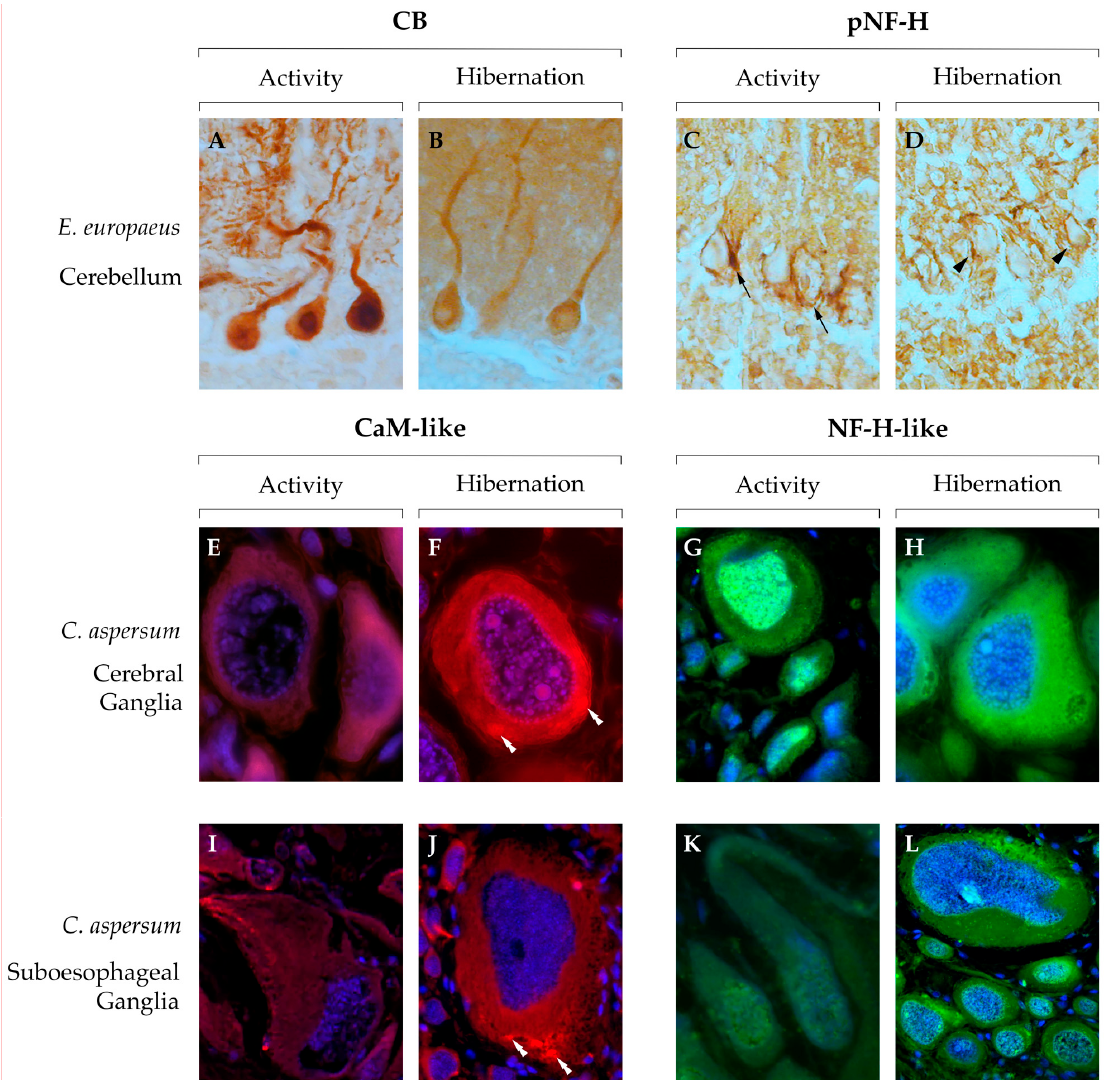
Figure 3. Comparison of immunohistochemistry staining for CBPs and NF-H between activity and hibernation in vertebrate (European hedgehog, A – D ) and invertebrate (garden snail, E–L ) models. In the cerebellum of active hedgehogs, the cytoplasm and dendritic tree of Purkinje neurons showed strong CB labeling ( A ), while a visible decrease was detected after a long period of hibernation ( B ). NF-H immunopositivity was present in axons and terminals around Purkinje cells somata during activity ( C , arrows), and strongly decreased after a long period of hibernation, when it was observed only in few terminals ( D , arrowheads). In the cerebral ( E – H ) and suboesophageal ( I – L ) ganglia of the garden snail, a significant increase in the number of positive neurons and intensity of immunoreactivity for CaM-like during hibernation ( F , J ) was accompanied by an increased recognition of epitopes by anti-NF-H antibodies ( H , L ) with respect to activity ( E , I and G , K , respectively). Throughout the snail CNS, several neurons showed hibernation-specific aggregates of CaM-like in the cytoplasm ( F , J , double arrowheads). Experiments were carried out as described in [127,133]. Magnification: 40 × ( A–D , I–L ); 60 × ( G ); 100 × ( E , F , H ).